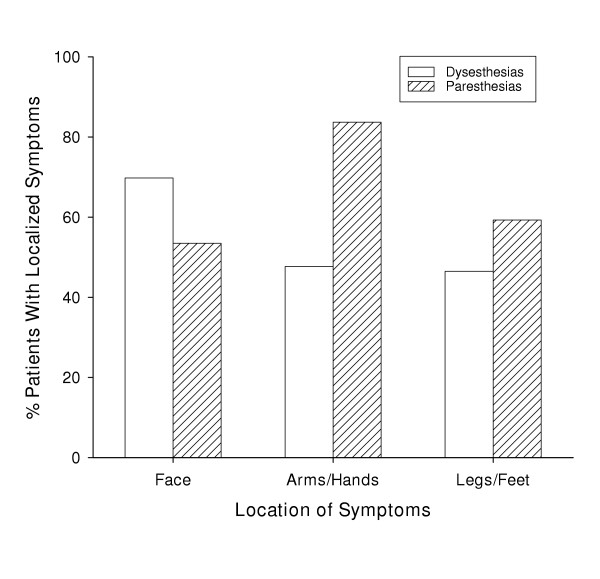
Location of dysesthesias/paresthesias during therapy with oxaliplatin and capecitabine (n = 86 subjects).